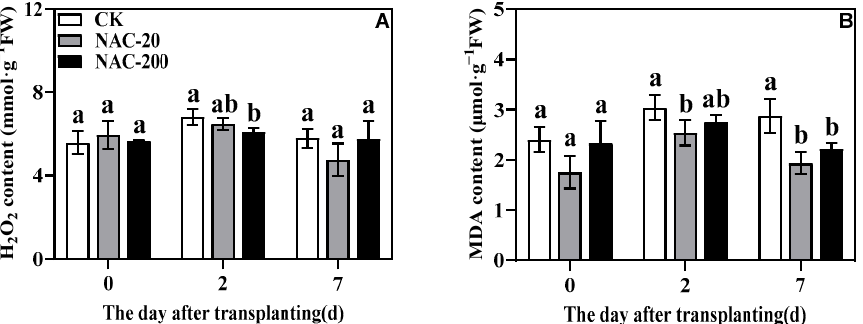
Figure 9. Effects of different concentrations of NAC on H 2 O 2 ( A ) and MDA ( B ) content. CK, 0 µ m; NAC-20, 20 µ m; NAC-200, 200 µ m. Data are means ± SD ( n = 3). The different letters following average values indicate significant difference (Duncan, p < 0.05).